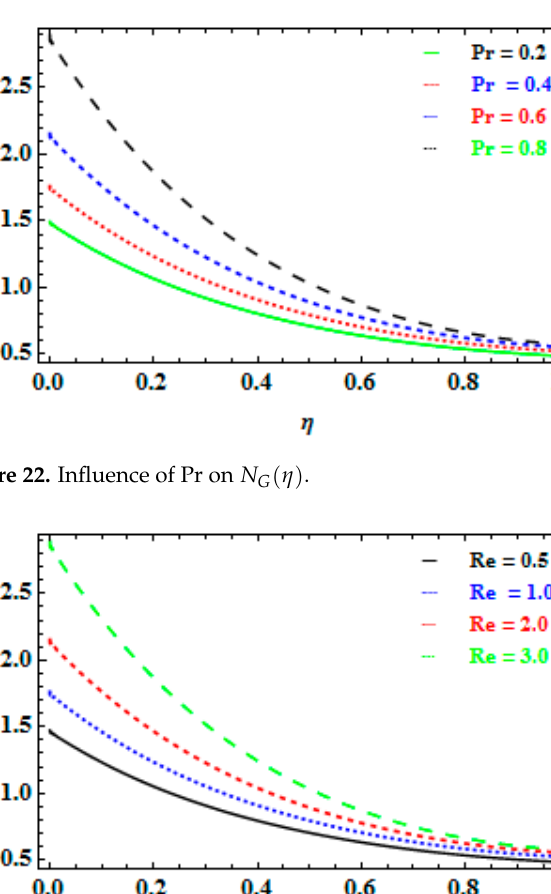
Figure 21. Influence of Br on 𝐵𝑒 ( 𝜂 ) .